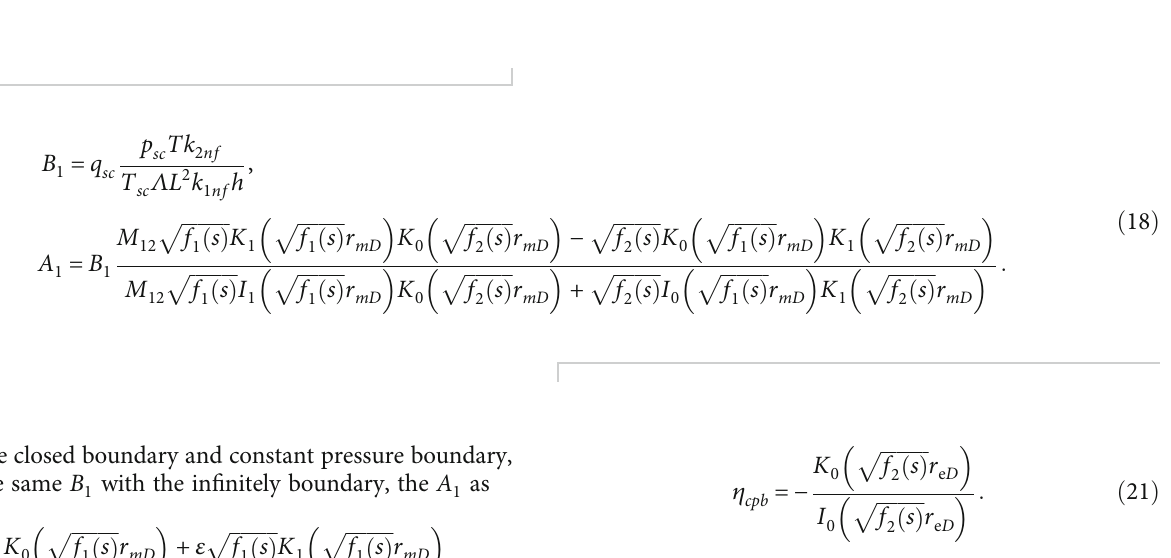
ffiffiffiffiffiffiffiffiffiffi